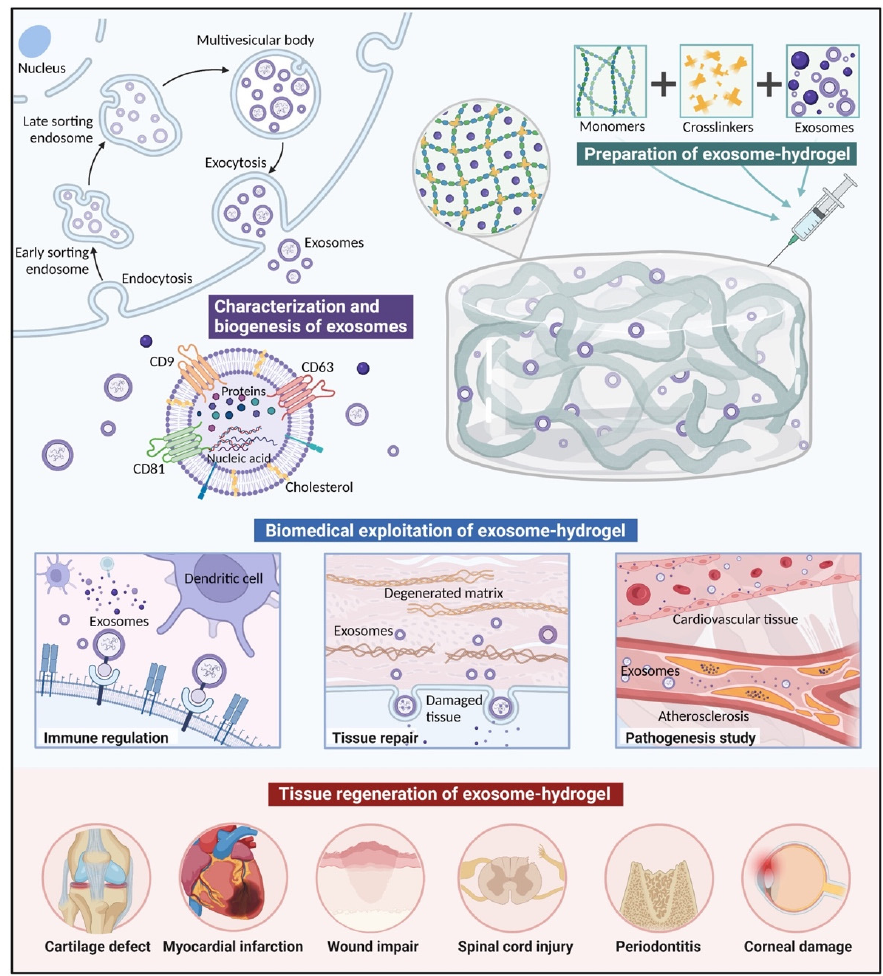
Figure 1. Hydrogels for exosome delivery in biomedical applications. Inward budding of the cellular plasma membrane results in the formation of endosomes, and the continuous inward invagination of the limiting membrane produces multivesicular bodies (MVBs). MVBs then fuse with the lysosome or plasma membrane, while the vesicles are released into the extracellular matrix to form exosomes. The secreted exosomes mainly contain proteins, nucleic acids, and lipids. The proteins contained in exosomes can be divided into two categories: one includes those commonly expressed in exosomes which can be used as markers (CD9, CD63, and CD81); the other includes the specific proteins from the parent cells. Hydrogels, as hydrophilic polymer networks, can encapsulate exosomes, overcoming the issue of low tissue retention and ensuring a controlled-release platform to localize their activity. Composite exosome–hydrogel systems have been applied in fields including tissue engineering and the study of pathogenesis. (Created with https://biorender.com/ accessed on 17 April